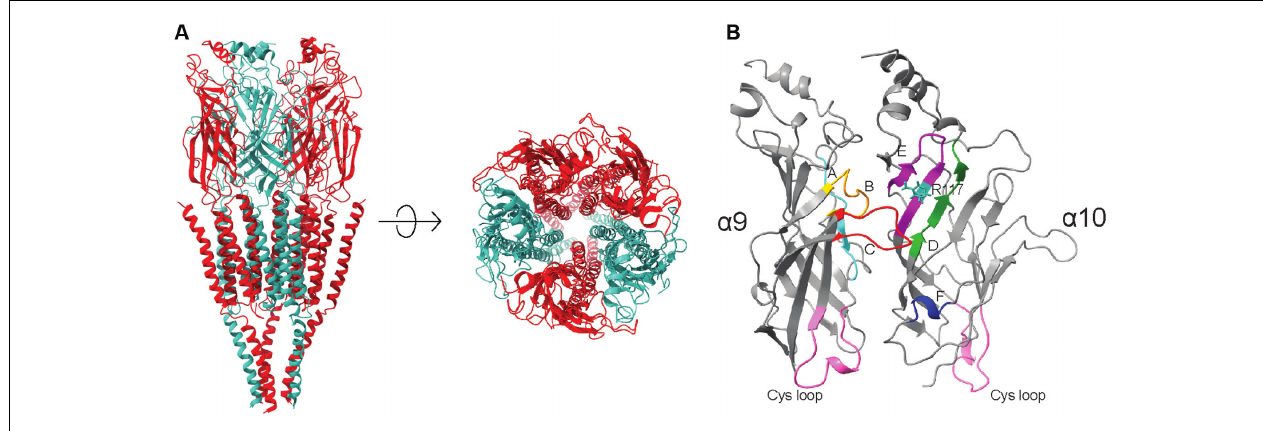
FIGURE 1 | (A) Ribbon structure of a pentameric nicotinic acetylcholine receptor, showing the arrangement of subunits around the channel pore. (B) Detailed view of the ligand binding site of an α 9 α 10 nAChRs receptor. The locations of the conserved loops that contribute to the binding site are highlighted in colour. The Cys-loops are highlighted in